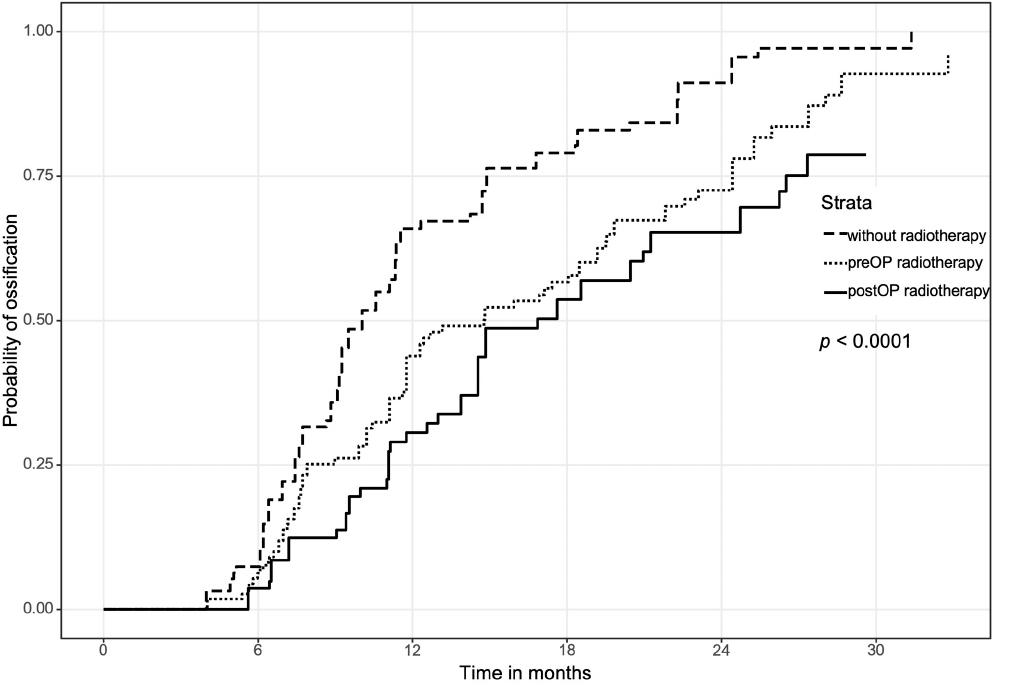
Figure 2. Overall complete ossification for every point of contact depending on radiotherapy.